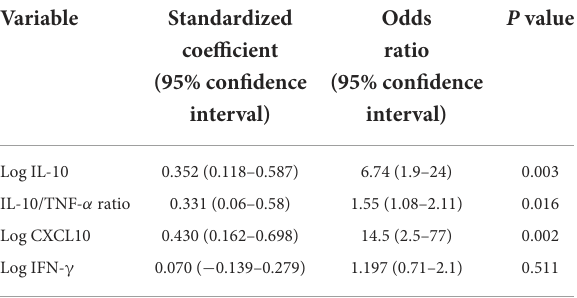
TABLE 4 Multivariate logistic analysis with Stress Hypeglicemia Ratio > 1.14 as the dependent